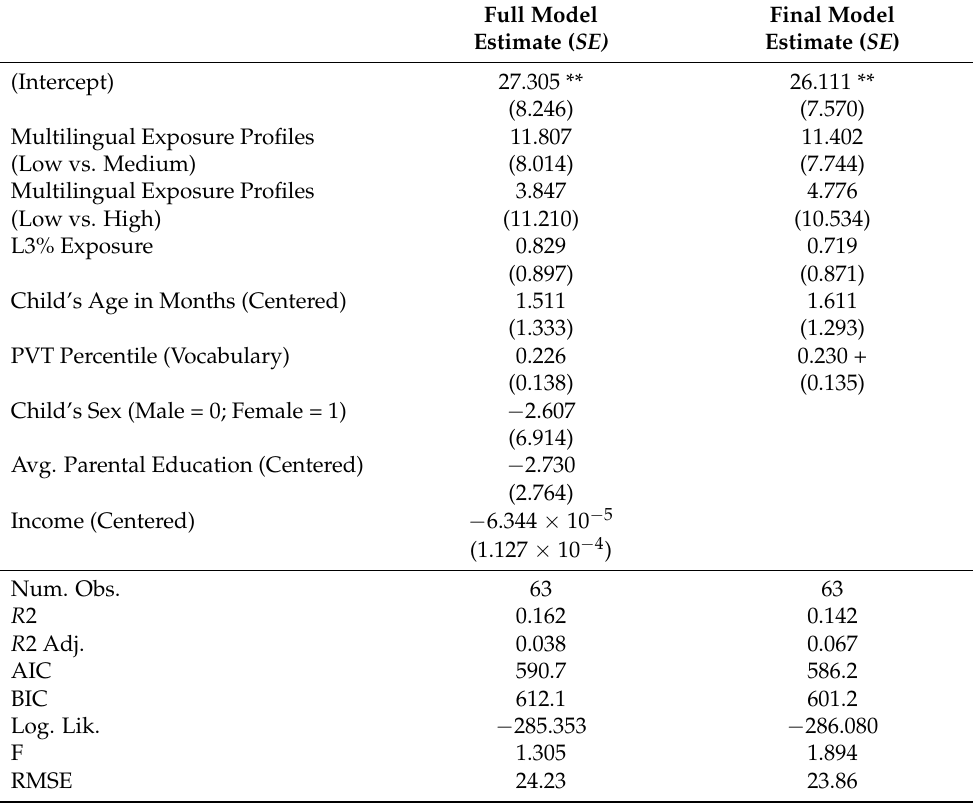
Table 4. Linear Regression Models for Analysis Approach 1-Latent Profile